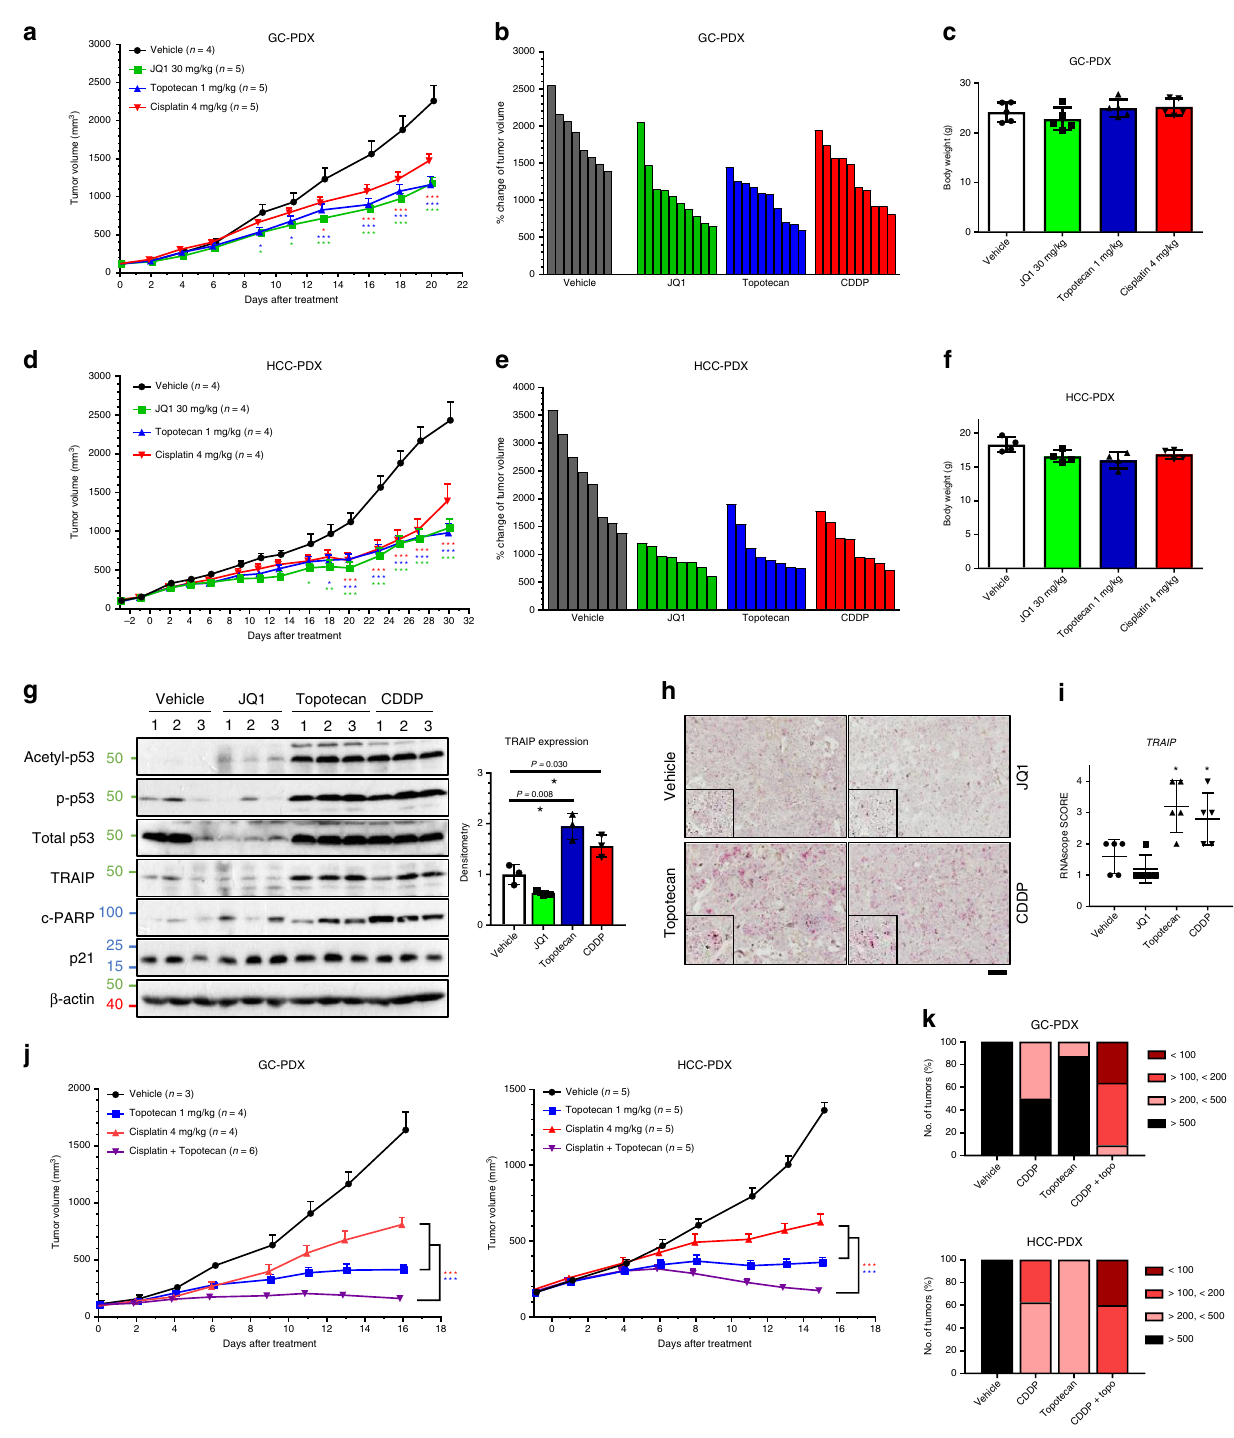
Methods Genomic analyses of human cancers . The pan-cancer mutation annotation fi le were downloaded from GDAC (version 2016_01_28 25 ). Mutations found on TP53 genes and the corresponding protein change were extracted for analysis. Cell culture . Cancer cell-lines (Calu-1, ChaGo-k-1, HCC70, H441, H520, H596, H661, H747, H1417, H2170, MDA-MB-468, SK-BR-3, SK-MES-1) and lung fi broblast cells (MRC-5) were obtained directly from the American Type Culture Collection (ATCC), while others (A549, BT-549, H1975, MIA-Paca-2, PANC-1) were provided by Ashok Venkitaraman (MRC Cancer Unit, Cambridge, UK). Cultures were maintained in a humidi fi ed 37 °C incubator, in culture medium (according to ATCC ’ s recommendation) supplemented with 10% fetal bovine